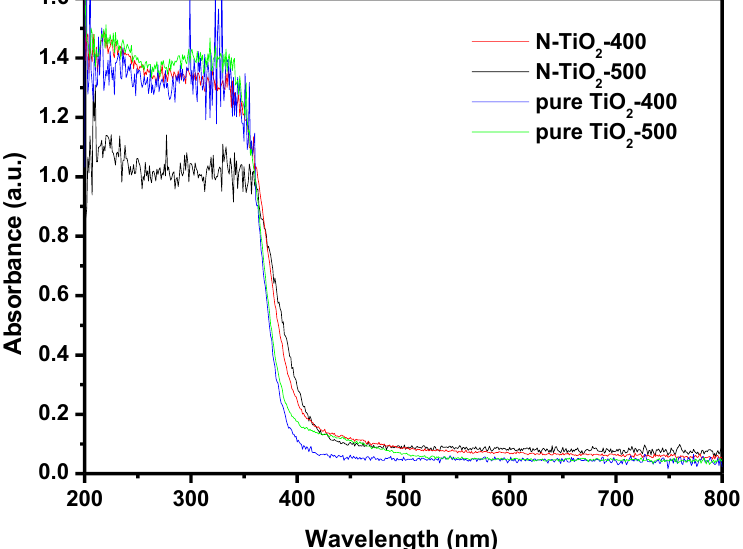
Figure 9. UV–vis absorption spectra of pure TiO 2 and N-TiO 2 with different calcination Figure 9. UV – vis absorption spectra of pure TiO 2 and N-TiO 2 with different calcination tempera- tures.